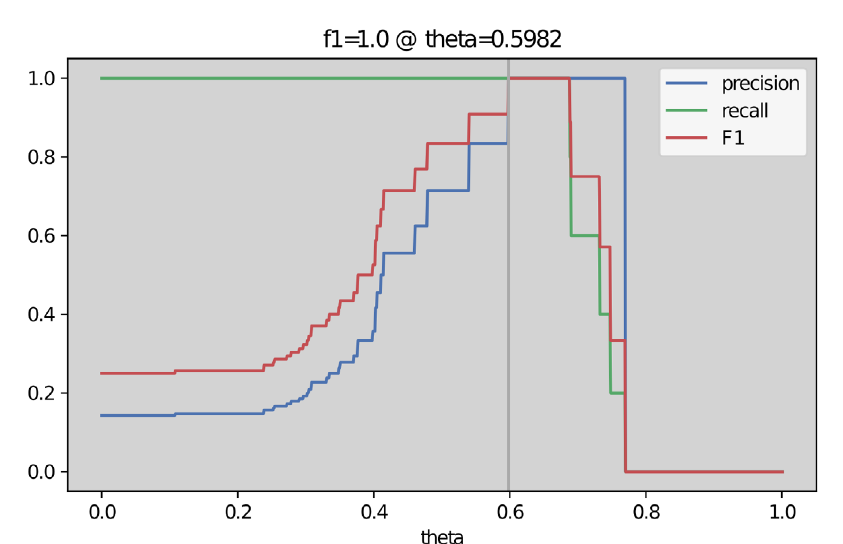
Fig. 2 Precision, recall, F1 graph for the calibration set run for verified texts from FgA 1772. F1 is a measure of accuracy, balancing precision and recall (harmonic